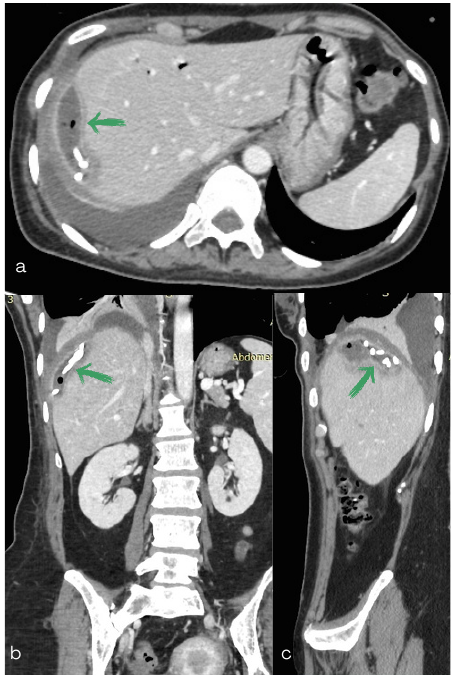
Figure 6. Computed tomography of the abdomen ( a ) axial ( b ) coronal and ( c ) sagittal section showing both pigtail drainage catheters as well as a capsular ring enhancement of the biloma (green arrow). Reduction in size of the two bilomas can also be